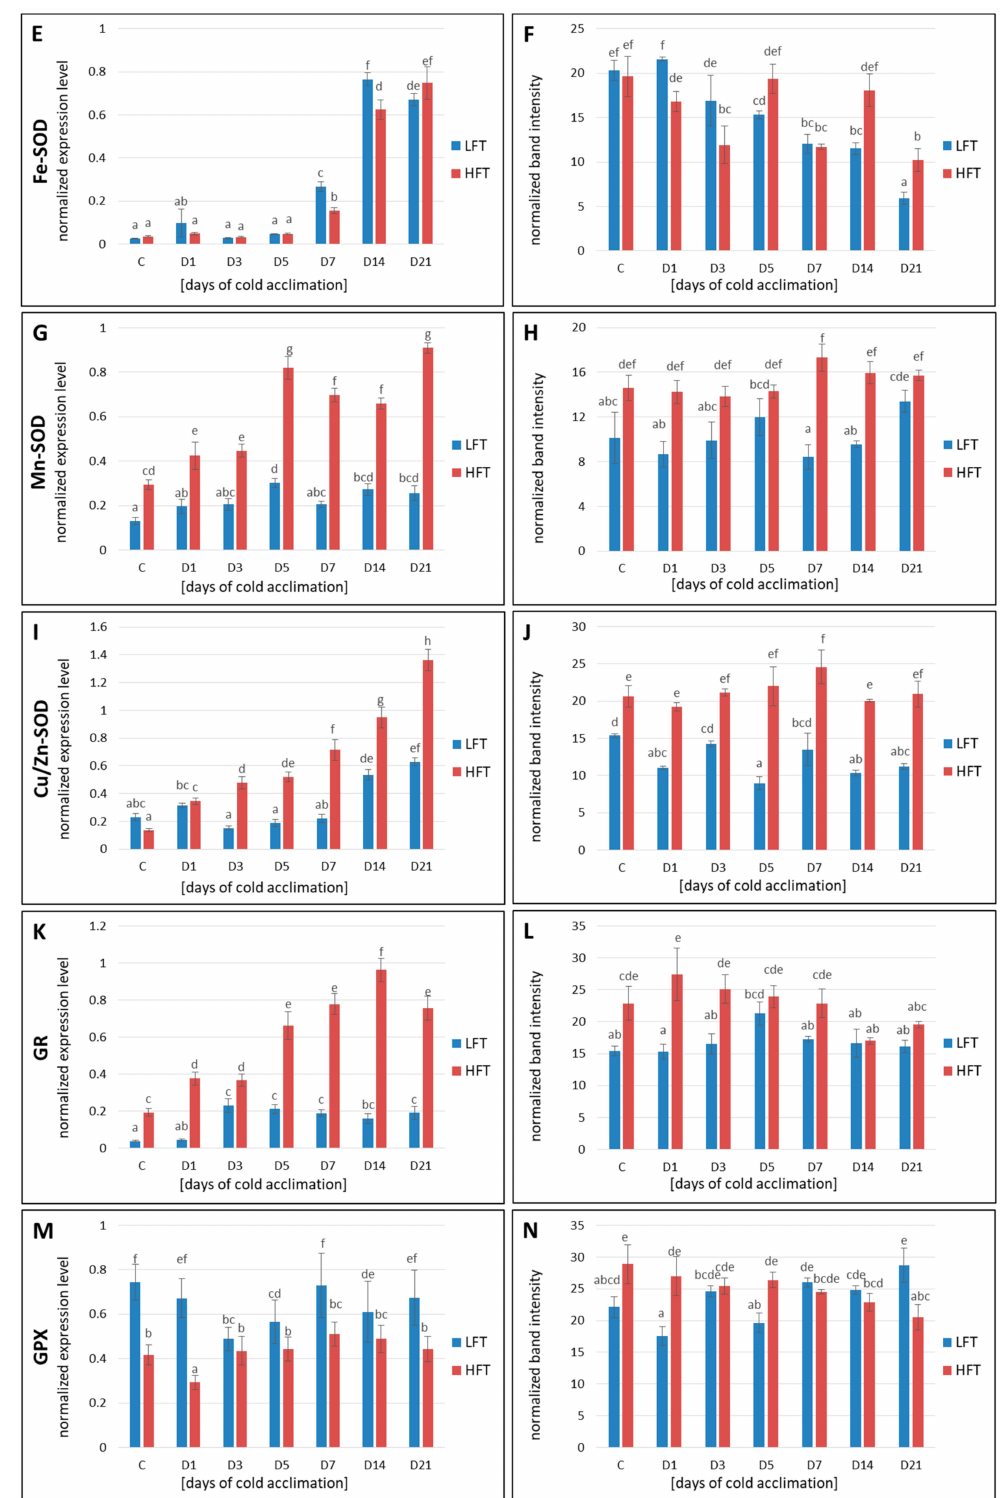
Figure 6. Transcript accumulation levels ( A , C , E , G ,I, K , M ) of chloroplastic L-ascorbate peroxidase (APX) ( A ), catalase (CAT) ( C ), chloroplastic iron superoxide dismutase (Fe-SOD) ( E ), mitochondrial manganese superoxide dismutase (Mn-SOD) ( G ), chloroplastic copper / zinc superoxide dismutase (Cu / Zn-SOD) ( I ), chloroplastic glutathione reductase (GR) ( (cid:26) extbfK), chloroplastic glutathione peroxidase (GPX) ( M